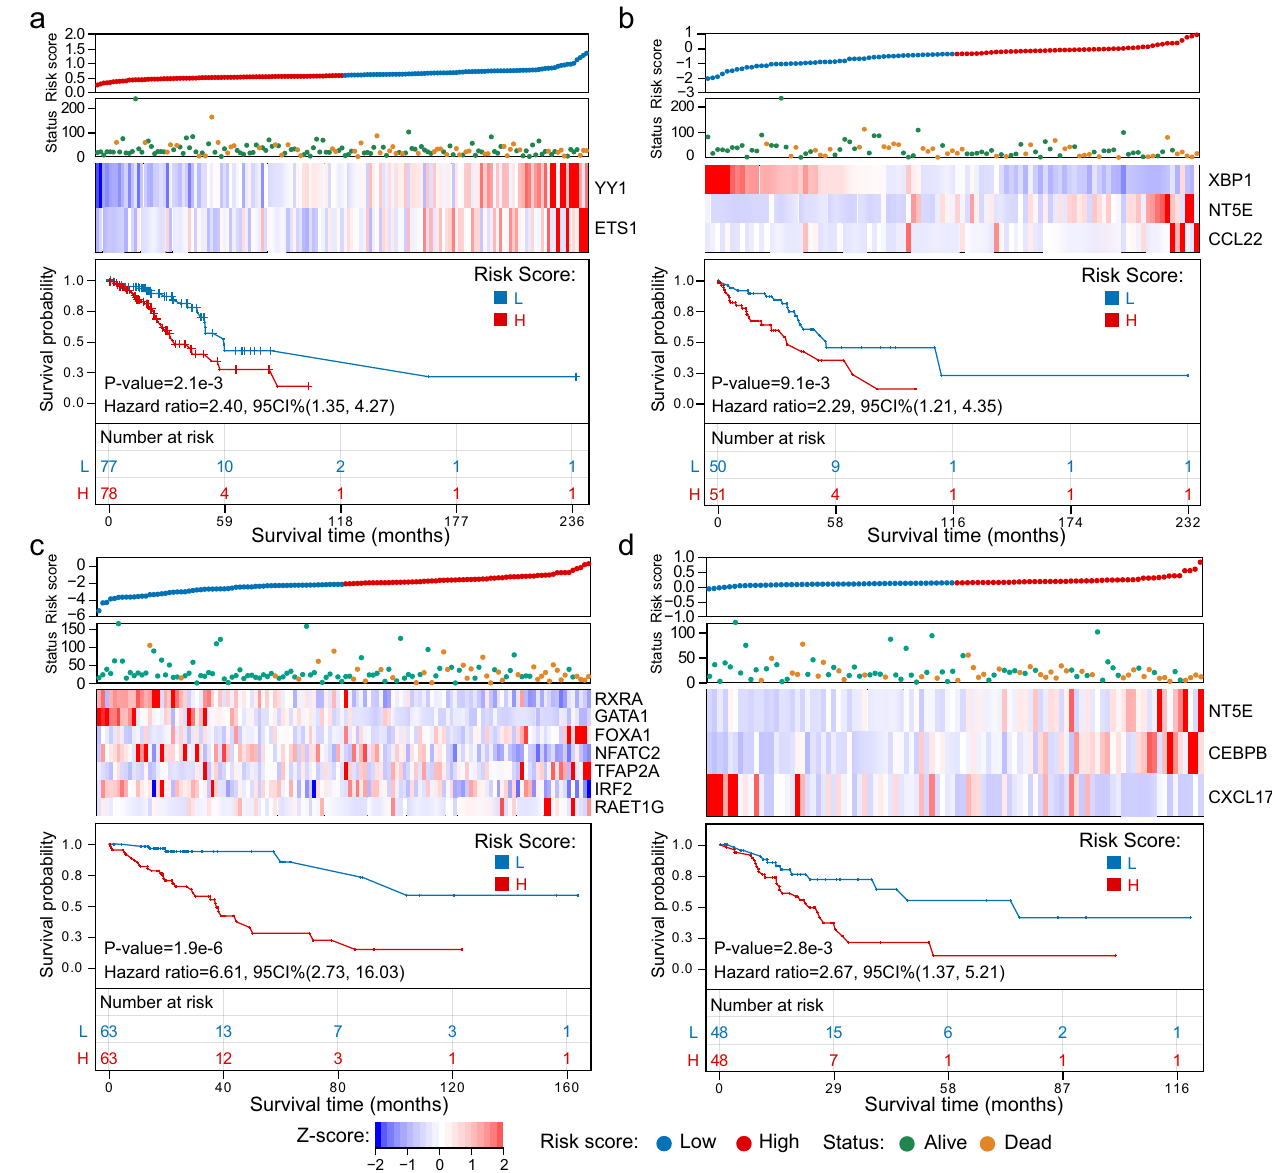
Fig. 8 Lasso-Cox prognostic risk scoring models. a , b , c and d are the results of Lasso-Cox prognostic risk scoring models of Cluster 1, 2, 3 and 4, respectively. According to the Risk Score, the samples were divided into high-Risk Score group and low-Risk Score group 1:1. The Kaplan – Meier curve showed the relationship between Risk Score and